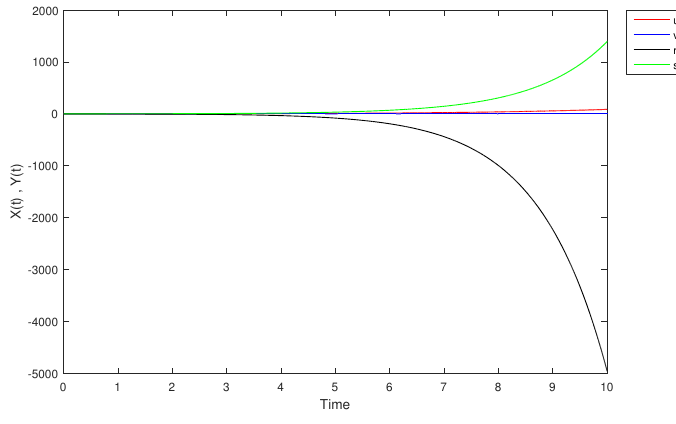
Figure 23. The solution of (12) at α = 0.0. At α -level = 0.5, the solution is shown in Figure 24: